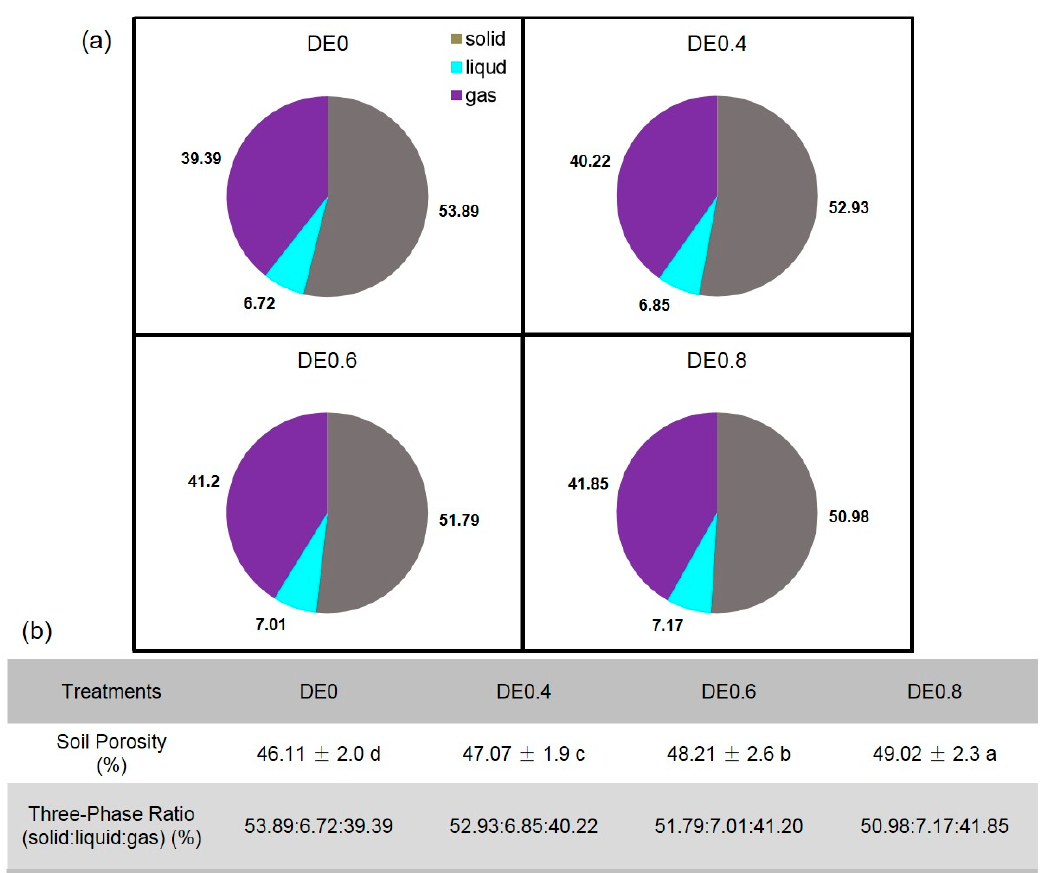
Figure 3. Effects of different dosages of DewEco (DE) on three-phase ratio (a) and sandy soil porosity (b) . DE 0, 0.4, 0.6 and 0.8 refer to DewEco dosages of 0, 0.4, 0.6 and 0.8 g·kg − 1 sandy soil, respectively. Values within a row followed by different letters are significantly different at p ≤ 0.05. Table 1. Effects of different dosages of DewEco on soil pH, EC, organic matter and nutrient contents.